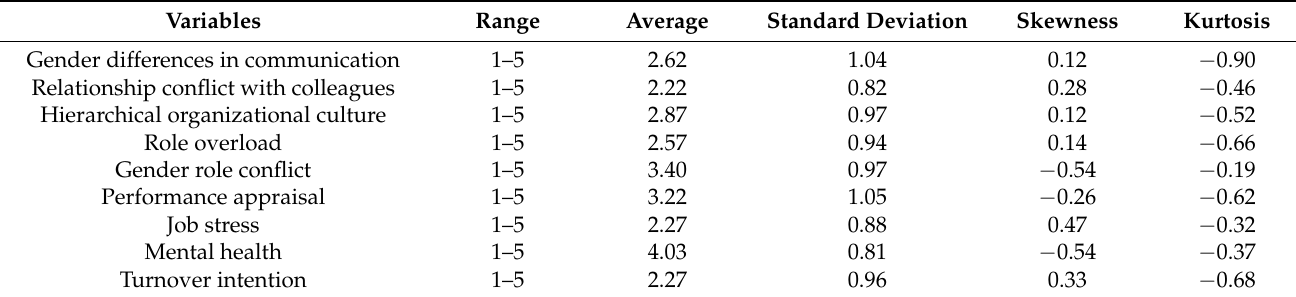
Table 6. Descriptive statistics analysis